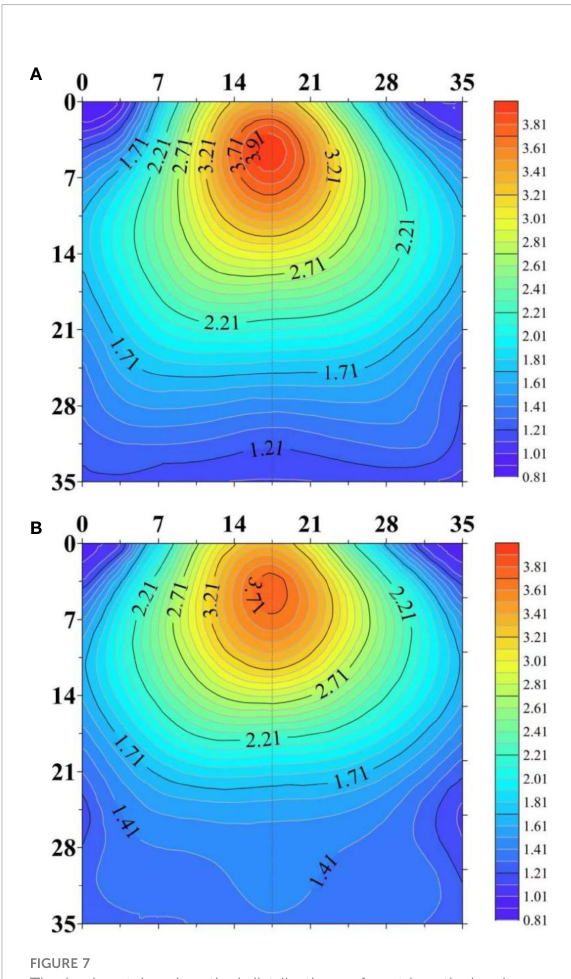
FIGURE 7 The horizontal and vertical distributions of root length density (RLD, cm cm -3 ) in the soil pro fi le under well-watered (A) and water-stressed (B) conditions. The fi gure is adapted from Figure 6 in Shabbir et al.